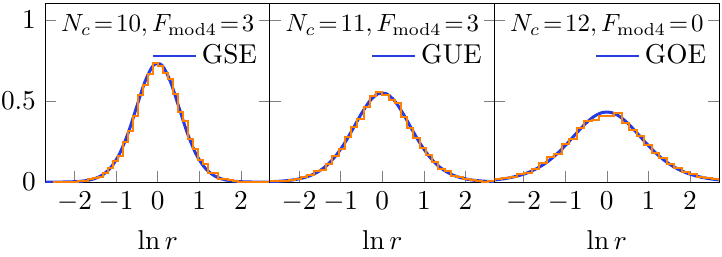
Figure 7 . Distribution of the ratio r of two consecutive level spacings of M in (5.1) with p = 4. The number of random samples used for averaging was 180 for N c = 10, 120 for N c = 11, and 40 for N c = 12. The blue lines are surmises for the RMT classes in table